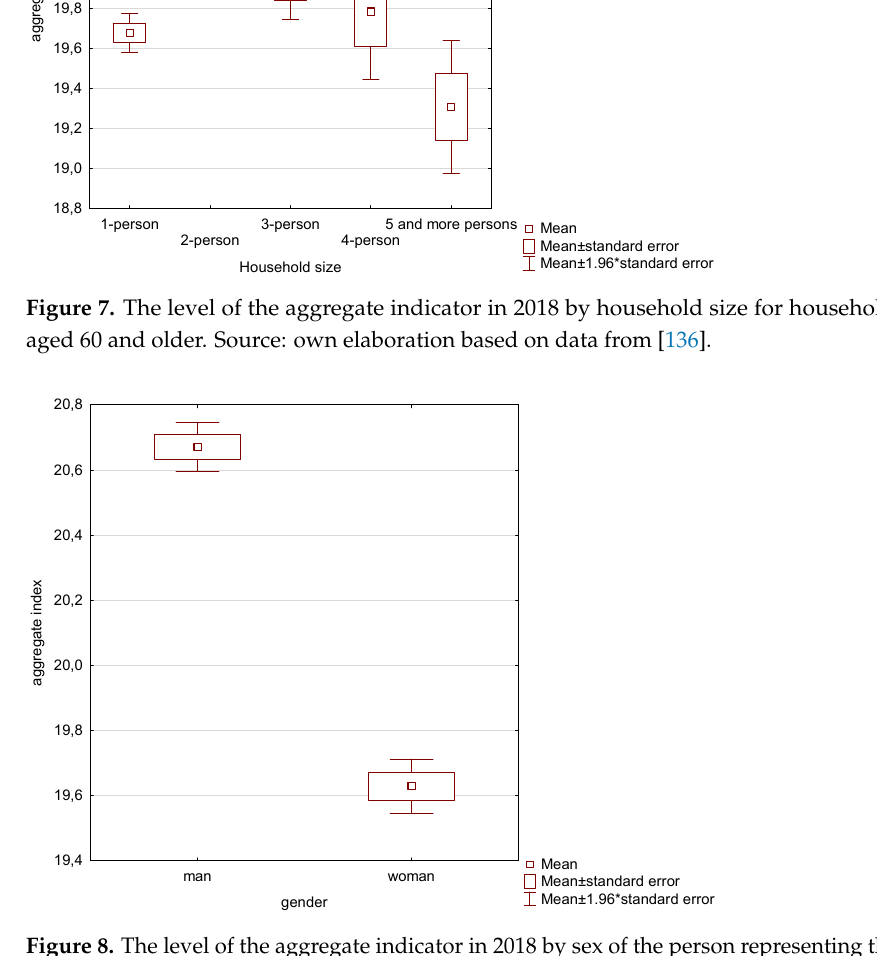
Figure 8. The level of the aggregate indicator in 2018 by sex of the person representing the household of people aged 60 and older. Source: own elaboration based on data from [136].